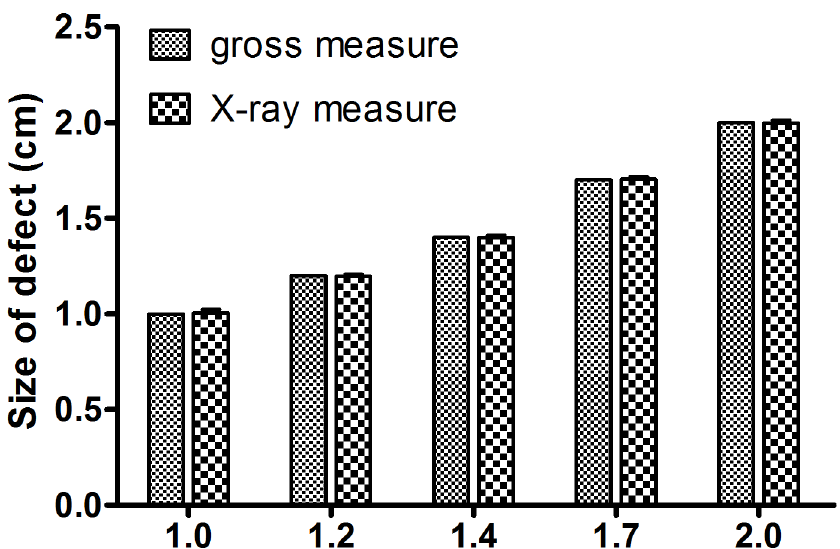
Fig 3. Measurement of defects on the X-ray just after operation. Size of different bone defects on the X- ray just after operation showed no statistical differences with the measurement of bone defects during operation ( P > 0.05).